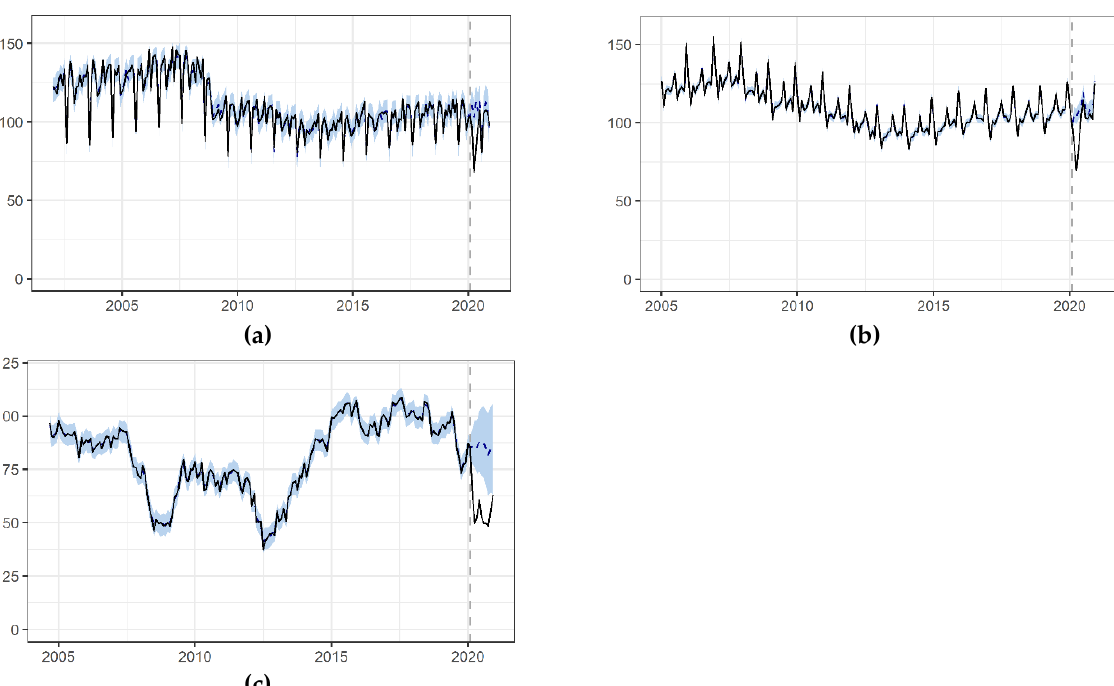
Figure 3. Impact of the COVID-19 crisis on supply and demand in Spain. ( a ) Industrial production index ( b ) Business turnover index ( c ) Consumer confidence index. Frequency: Monthly.